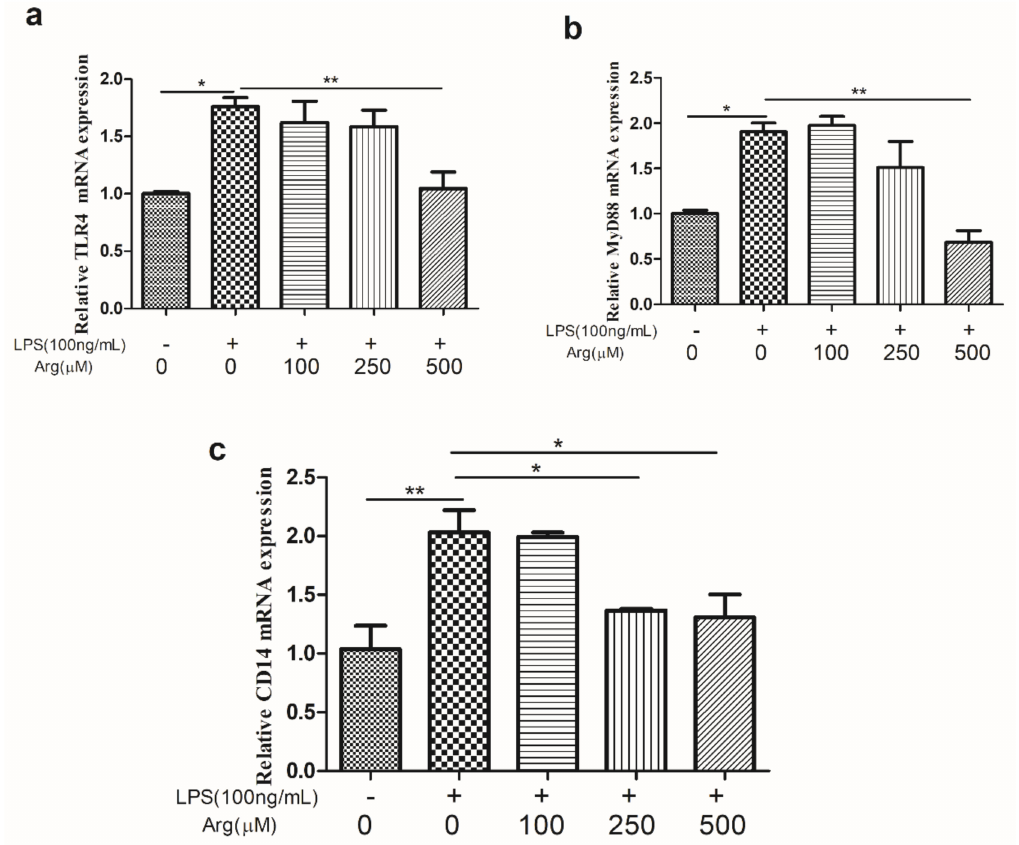
Figure 3. E ff ect of arginine on TLR4 , MyD88 and CD14 in LPS-treated IPEC-J2 cells. The abundance of ( a ) TLR4 , ( b ) CD14 , and ( c ) Myd88 mRNA in IPEC-J2 cells exposed to LPS (0 or 100 ng / mL) and LPS-treated cells were co-incubated with L-arginine (0, 100, 250, or 50 0 µ M) for 24 h. Results represent the mean ± SEM from four independent experiments. * p < 0.05; ** p < 0.01. TLR4 , Toll-like receptor 4; CD14 , cluster of di ff erentiation 14; MyD88 , Myeloid di ff erentiation primary response gene